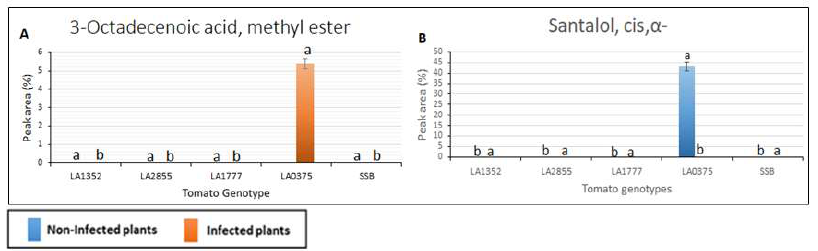
Figure 3. Volatile organic compounds detected only in susceptible tomato genotypes using gas chromatography/mass spectrometry. SSB—Super Stain B. The blue bar indicates the control group that was not inoculated (non-infected plants); the orange bar indicates the inoculated group (infected plants). Results are given as mean values ± standard deviations. Each compound is presented in a bar chart: ( A ) 3-Octadecenoic acid, methyl ester ( B ) Santalol, cis, α-. Values in the same bar chart with different letters are significantly different at p < 0.05.